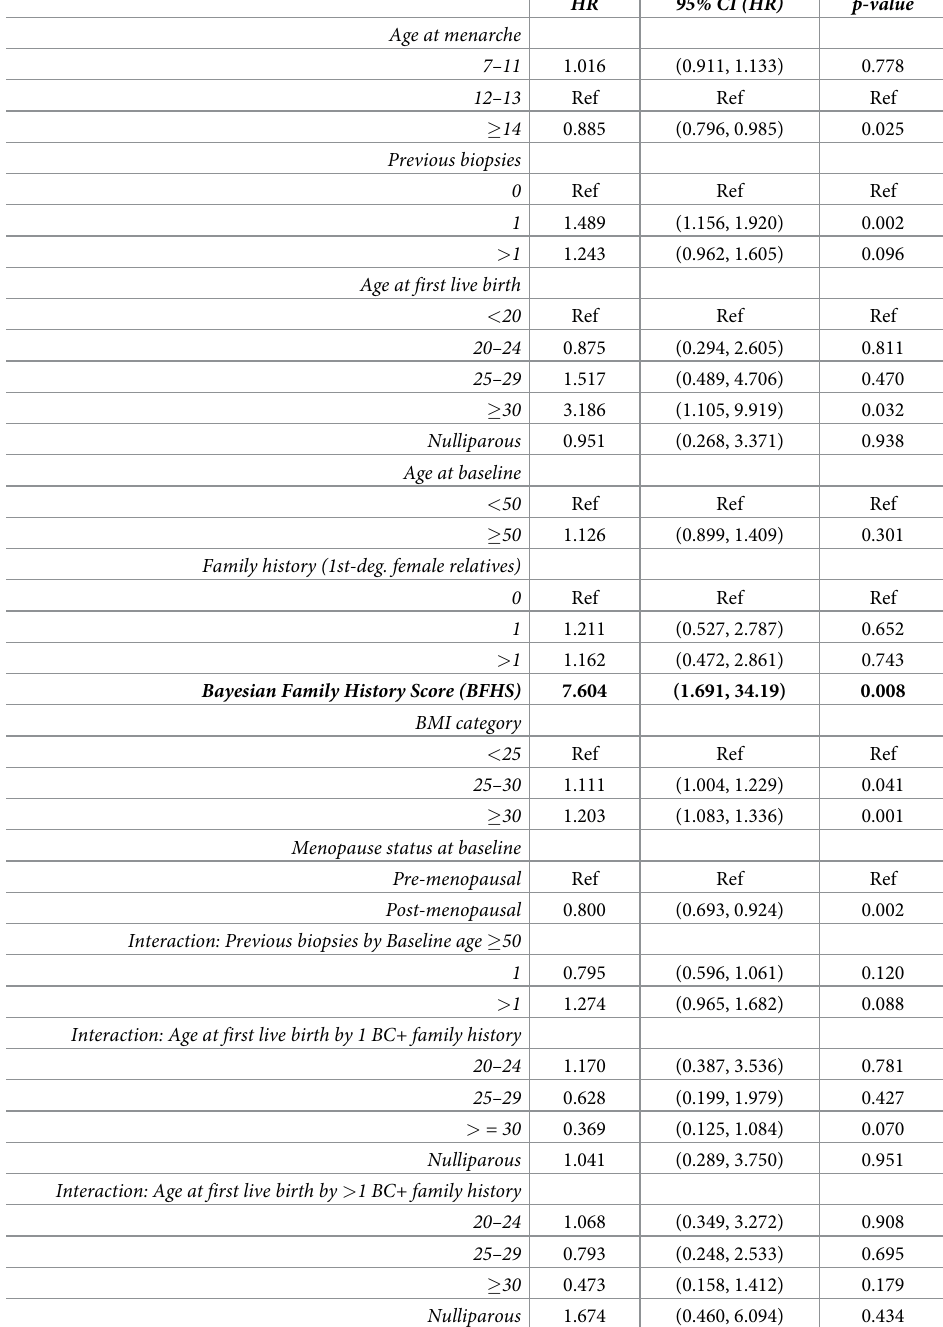
Table 4. Hazard ratios for best-fitting risk prediction model (Model